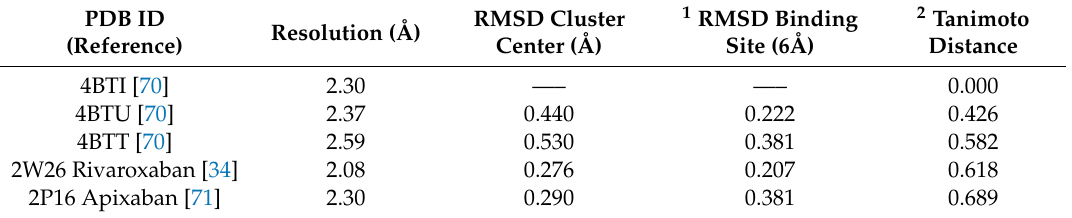
Table 1. Summary of crystal structures of Factor Xa-ligand complexes used in this study.